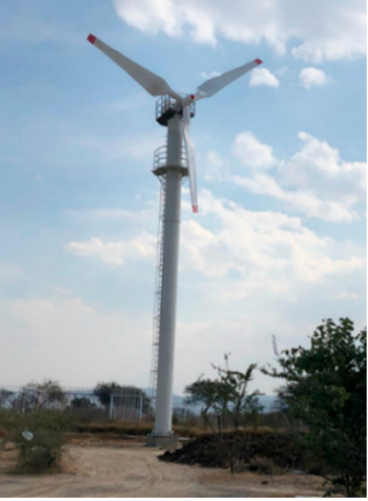
Figure 4. Three-blade wind turbine installed on Universidad Autónoma de Querétaro (UAQ). Table 1. Permanent magnet synchronous generator (PMSG) specifications.